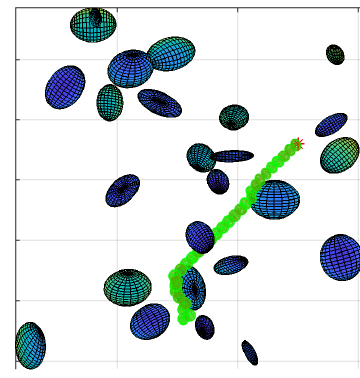
Figure 7. Room composed of ellipsoids looking from the outside (700 ellipsoids represent the walls, floor and roof, and 25 random ellipsoids represent the obstacles).